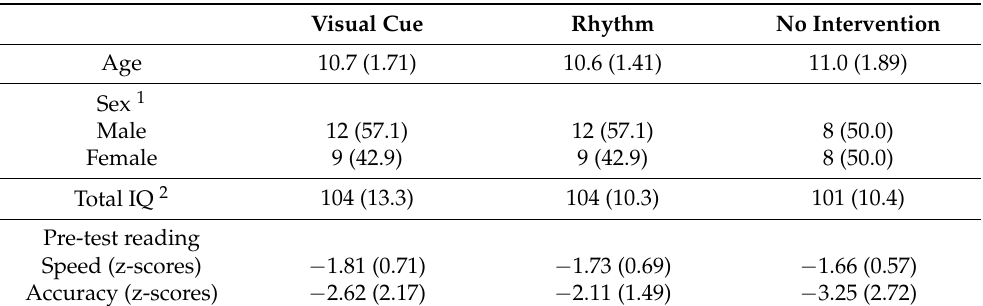
Table 1. Descriptive statistics (mean and standard deviations) of participants’ characteristics and baseline reading